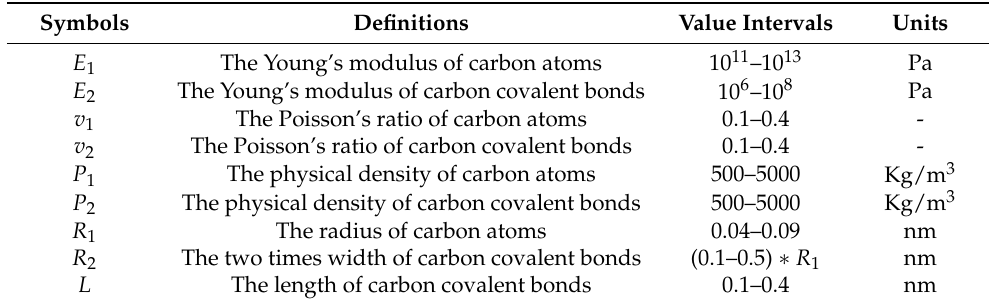
Table 1. Material and geometrical parameters in the finite plane element model of graphene.